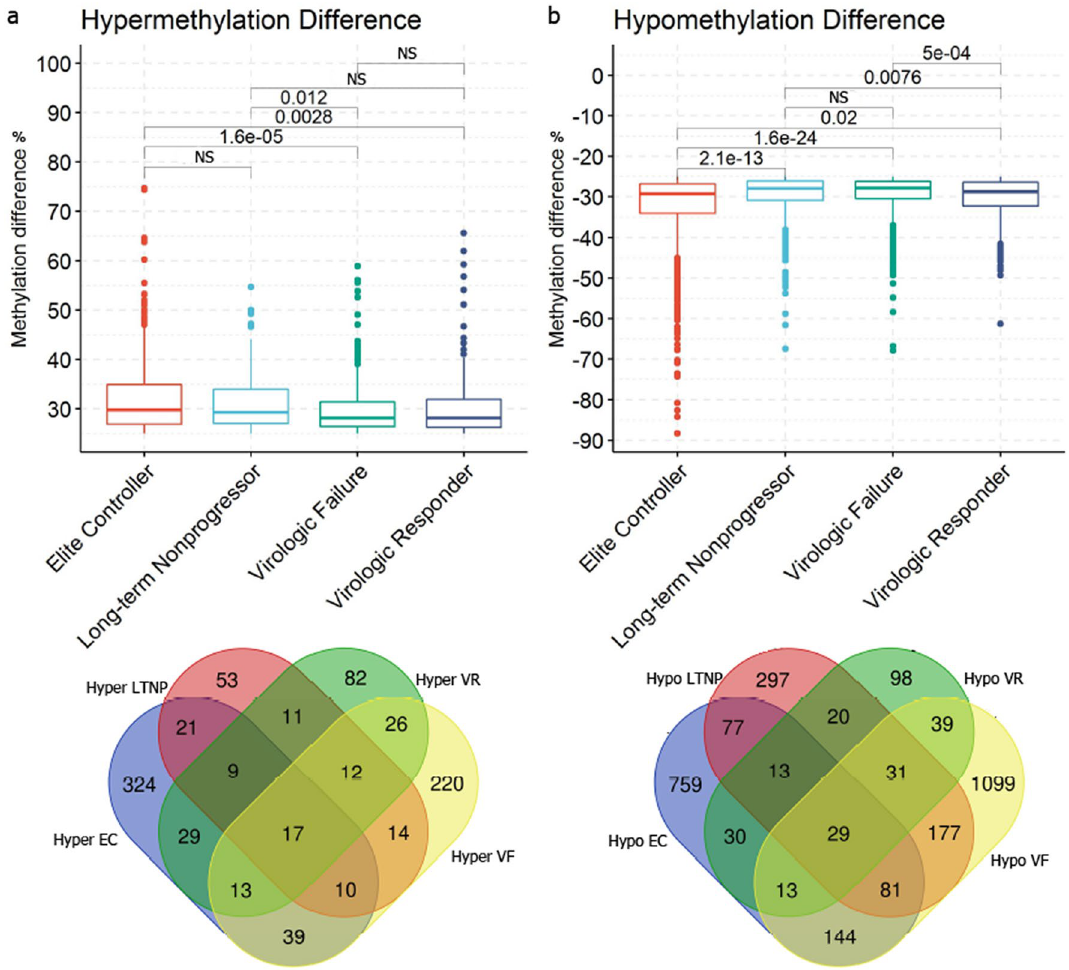
Figure 4. Differentially methylated regions within − 1 kb/ + 1 kb surrounding Transcription Start Sites. Significant regions (≥ 25% for methylation difference and q-value < 0.01) were annotated to find DMR-associated genes. DMR within − 1 kb/ + 1 kb flanking TSS was filtered for comparing hypo and hypermethylation differences. ( a , b ) Boxplots show comparisons of percentages for significant hypermethylated and hypomethylated promoters among HIV groups (Kruskal–Wallis rank-sum test < 0.001). P-values were calculated using the Wilcoxon rank-sum test with Benjamim-Hochberg correction for multiple comparisons and non- significant values were omitted. Venn-diagrams represent the number of DMR-associated genes detected for each group and their intersections. NS Non-significant